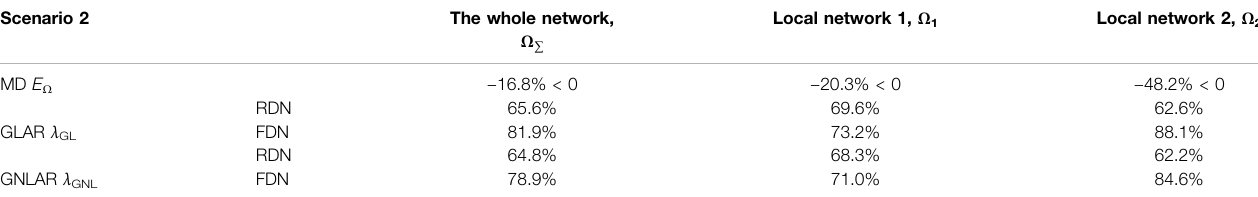
TABLE 3 | Matching degree and daily accommodation ratio of scenario 2. Scenario 2 The whole network,